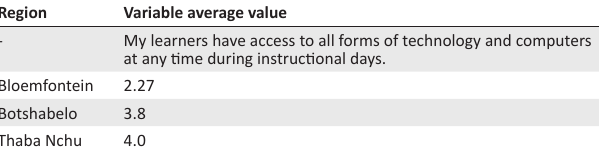
TABLE 9: Schools’ economic viability to incorporate technology in teaching of mathematics.